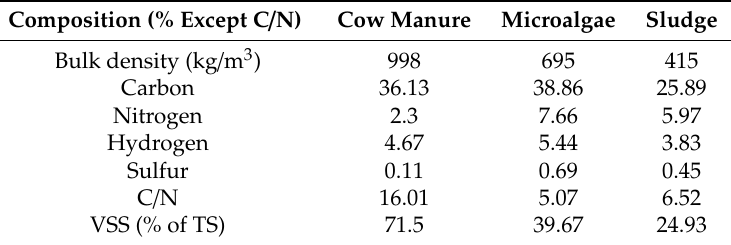
Table 3. Composition of feedstock for anaerobic